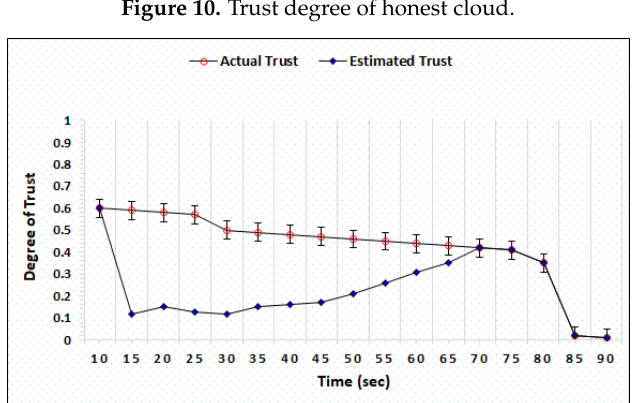
Figure 10. Trust degree of honest cloud.